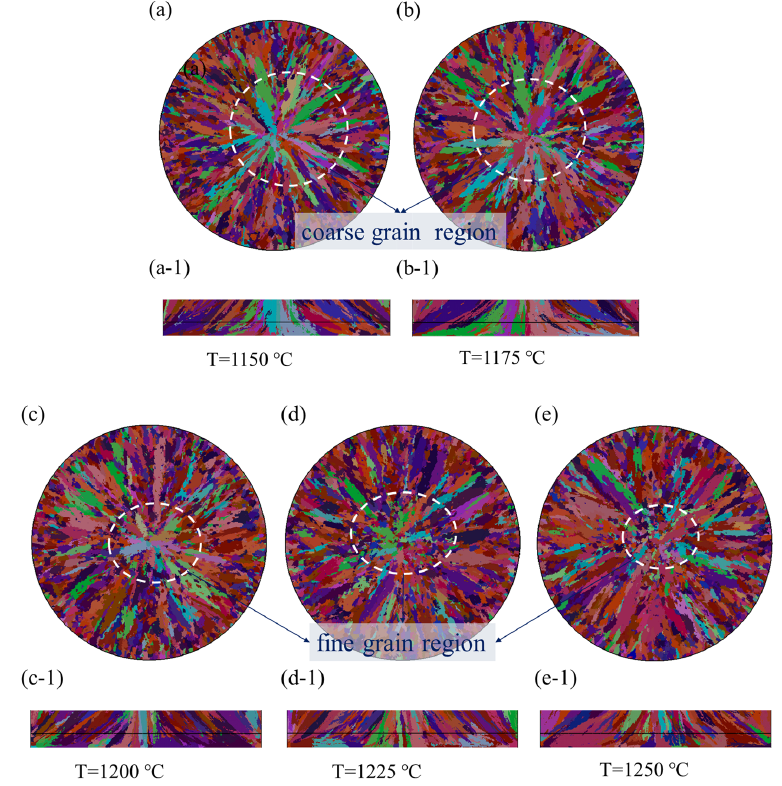
Figure 8. Simulated solidification structure under different casting temperature. ( a – e ) cross section of billet; and (a ‐ 1–e ‐ 1) longitudinal section of billet.